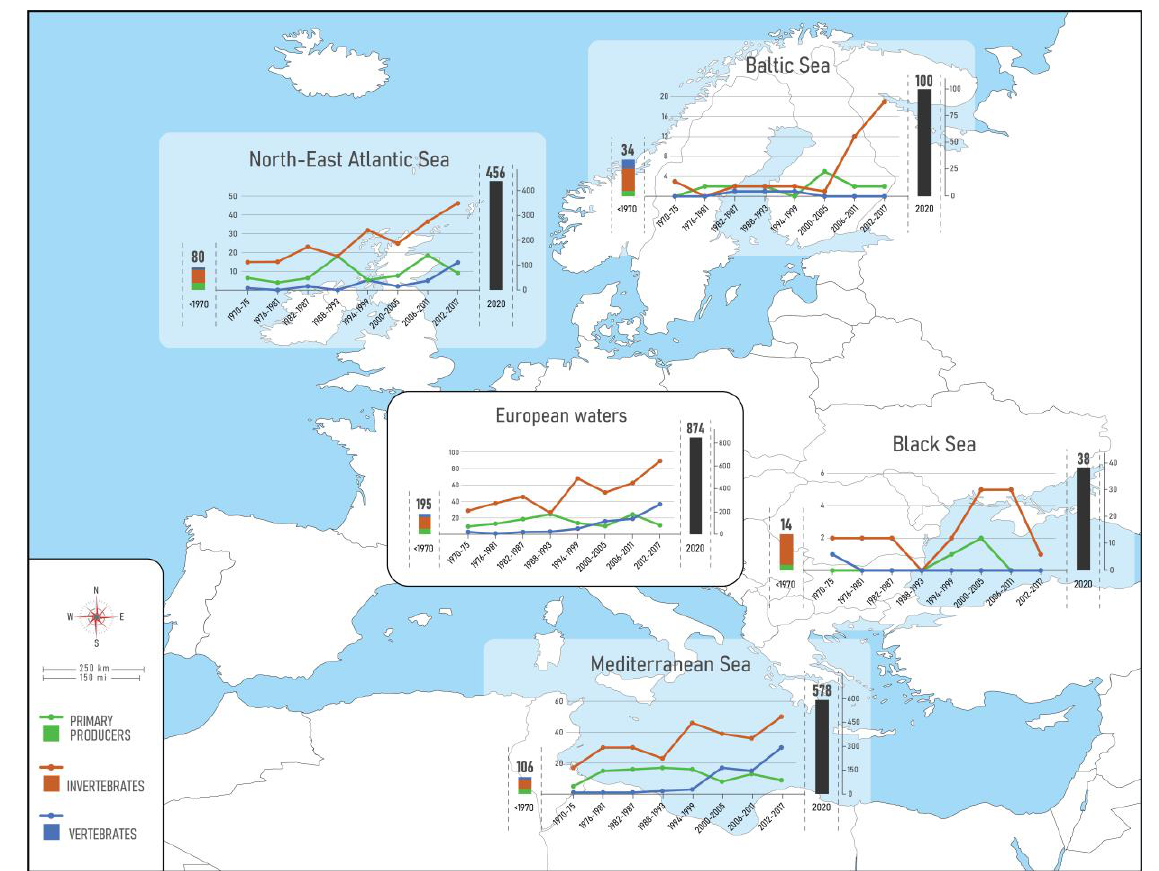
Figure 3. Status and trends in introduction of NIS in European seas. Bars depict the cumulative number of NIS, from historical times to 2020. Details for the status in 2020 (black bar) as in Figure 2. Lines show the trends in new NIS introductions per 6-year intervals from 1970 to 2017. Note: parasites/pathogens and microalgae were excluded from the trend analyses.